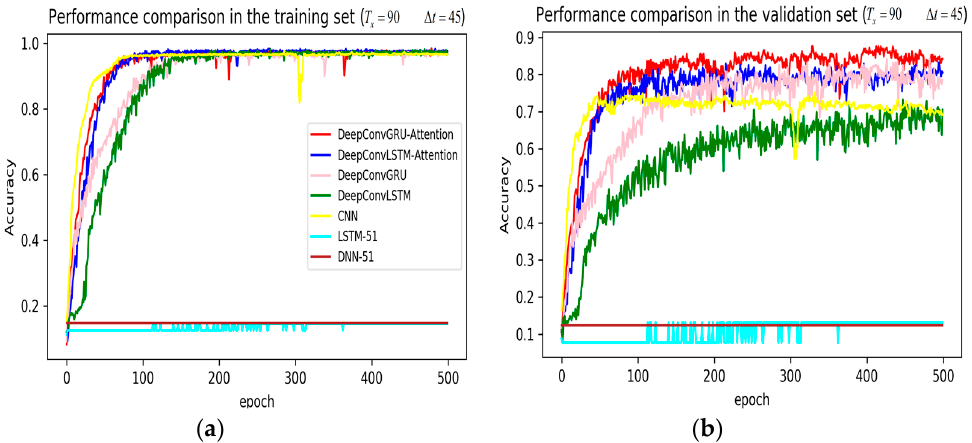
Figure 7. Performance comparison of different models in accuracy using 51 original features when setting T x to 90 samples and ∆ t to 45 samples. ( a ) Performance comparison in the training stage. ( b ) Performance comparison in the validation stage.